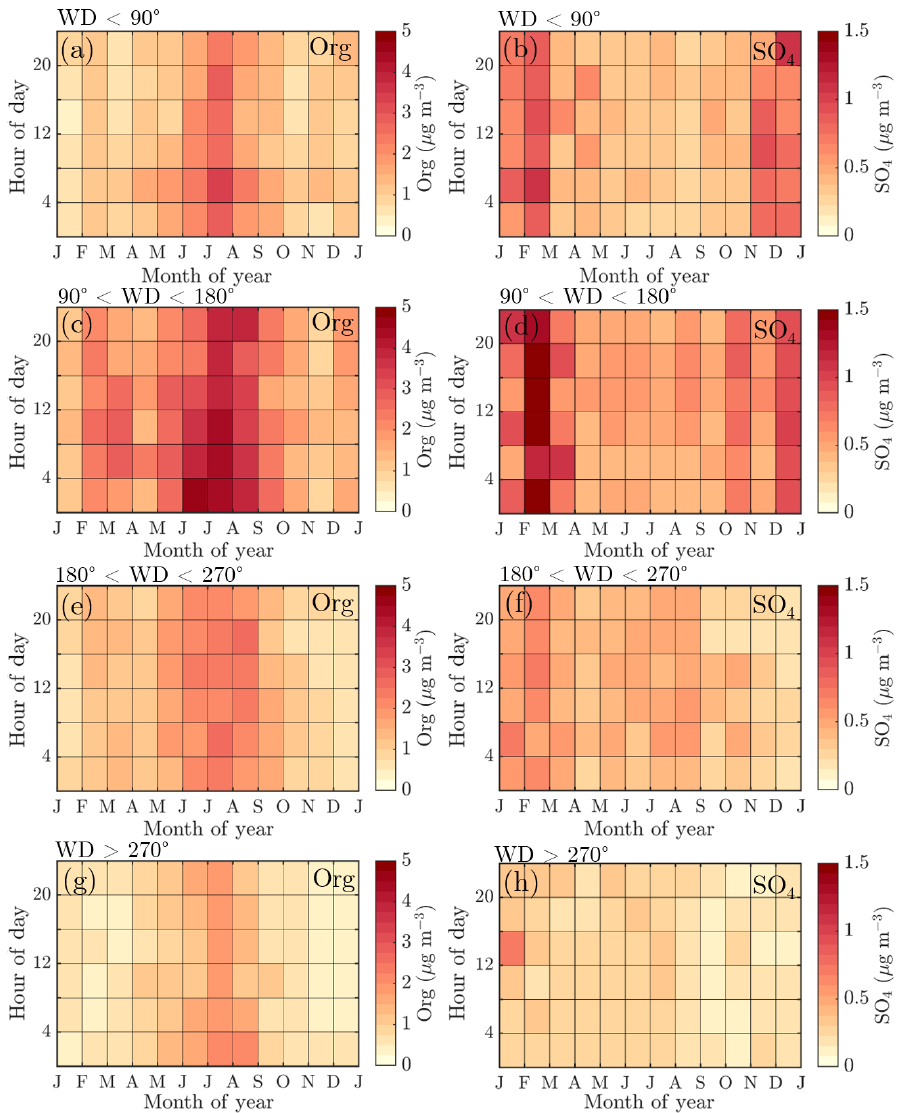
Figure 8. Diurnal cycles of organic aerosol and sulfate divided into different wind direction bins: (a–b) wind direction < 90 ◦ , (c–d) wind direction 90–180 ◦ , (e–f) wind direction 180–270 ◦ , and (g–h) wind direction > 270 ◦ . The y axes represent the local time of day (UTC + 2), and the x axes represent the time of the year. The color scales represent the organic aerosol and sulfate aerosol mass concentrations in µgm − 3 . Figure A1 introduces the likelihoods of each wind direction bin via a traditional wind rose plot.